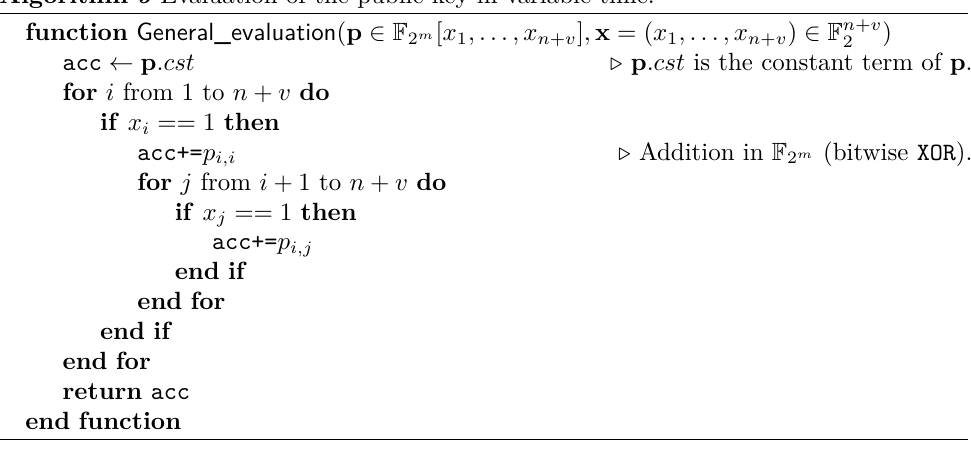
Algorithm 9 Evaluation of the public-key in variable-time.